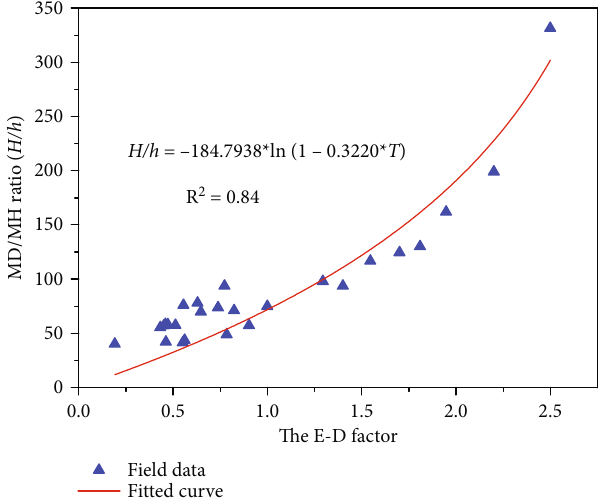
Figure 2: Relation curve between the E-D factor and MD/MH ratio.